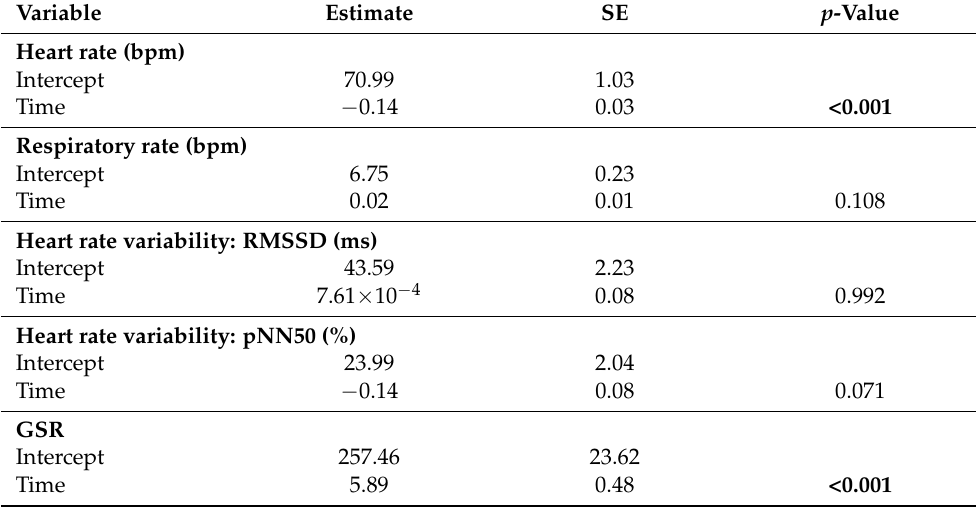
Table 6. Mixed-effects models of the dynamics of physiological stress measures during relaxation